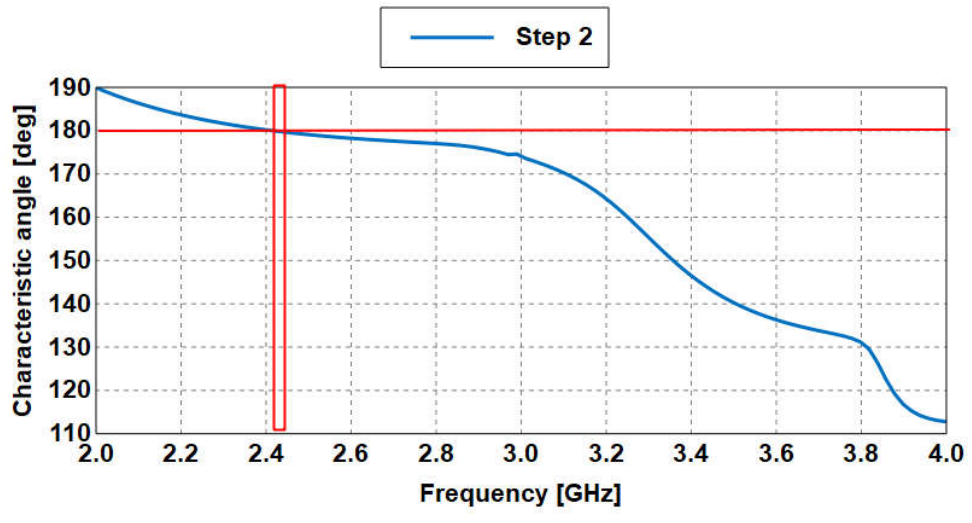
Figure 13. CA of Step 2 of the proposed design (mode 1).